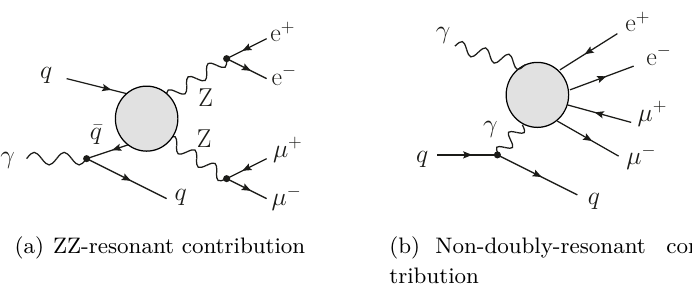
Figure 5 . Real-radiation contributions to four-charged-lepton production in the γq partonic chan- nel at NLO